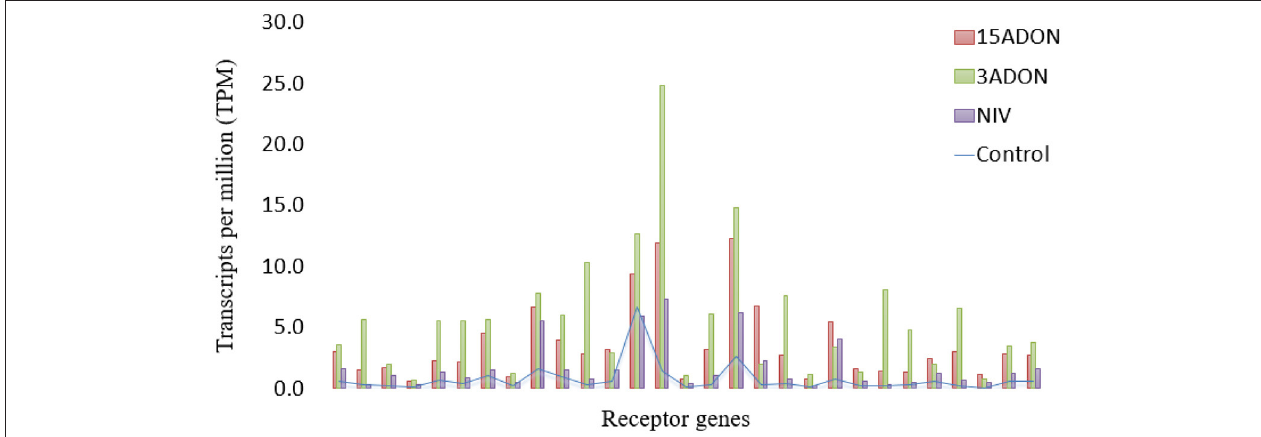
FIGURE 5 | Differentially expressed genes of receptor classification ( n = 29) for “CDC Kendall” in treatment groups (15ADON, 3ADON, and NIV) at 72 hpi vs. mock control expressed in transcripts per million (TPM).